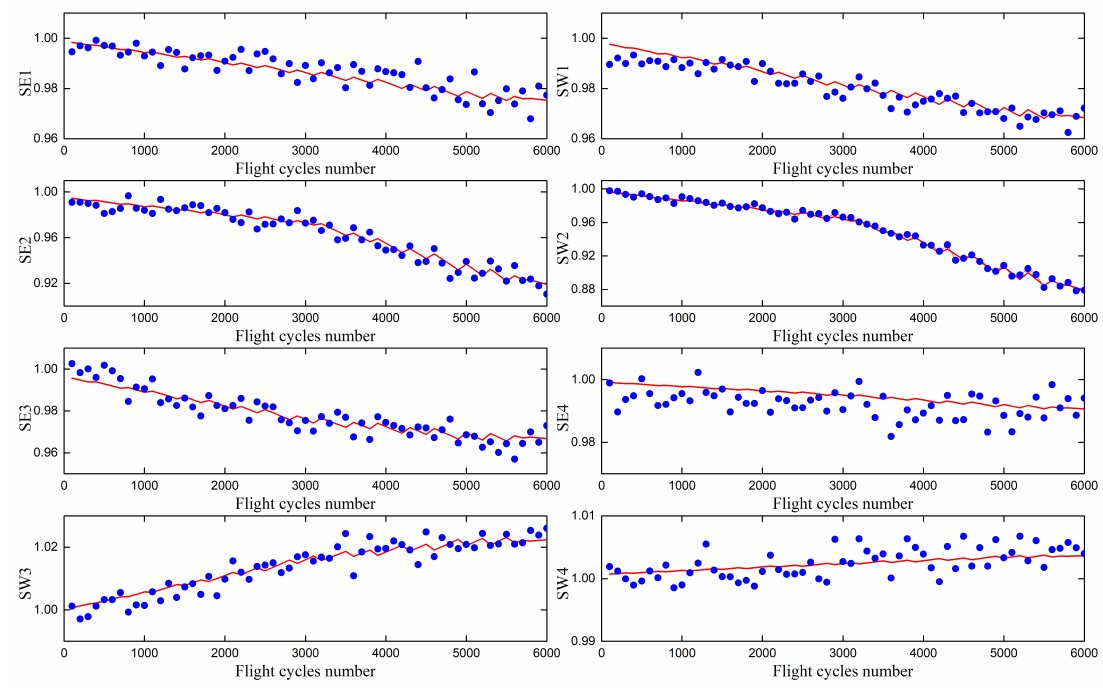
Figure 5. Health parameters degeneration estimation after different flight cycles through DKELMs algorithm (the line denotes target value and the point denotes estimated value).